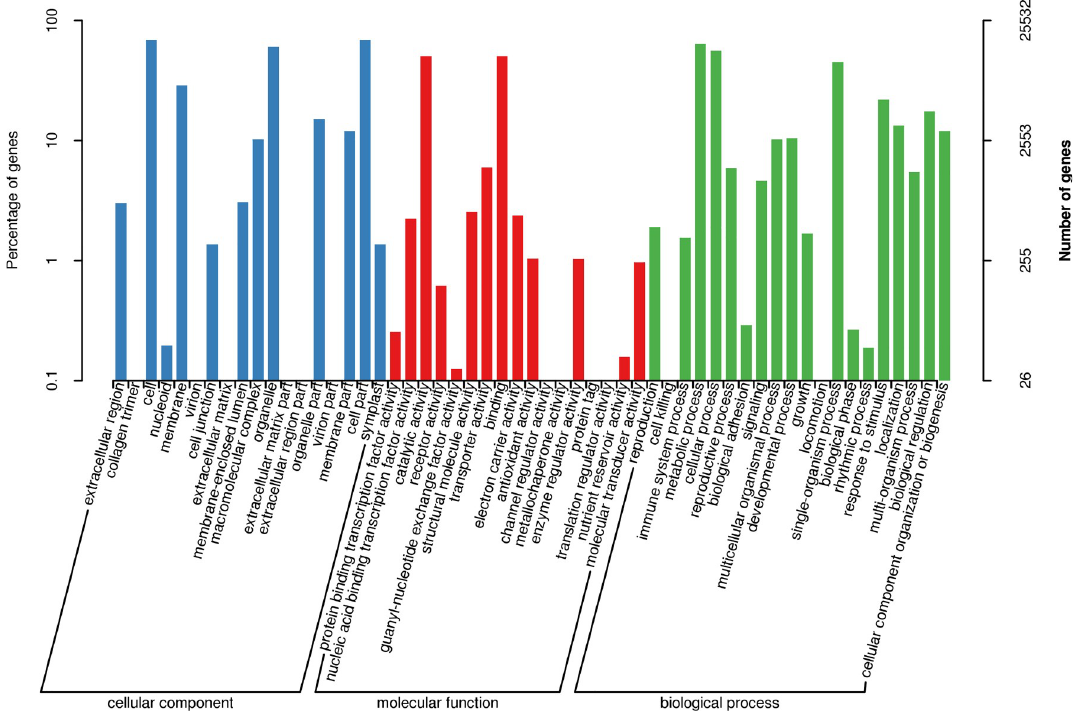
Fig 3. GO function classification of